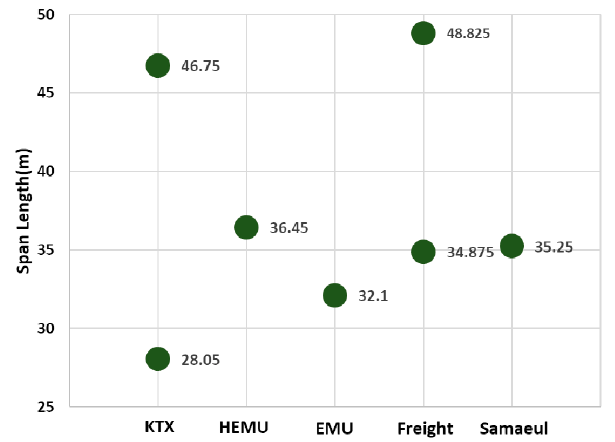
Figure 6. Resonance suppression span length per type of train.